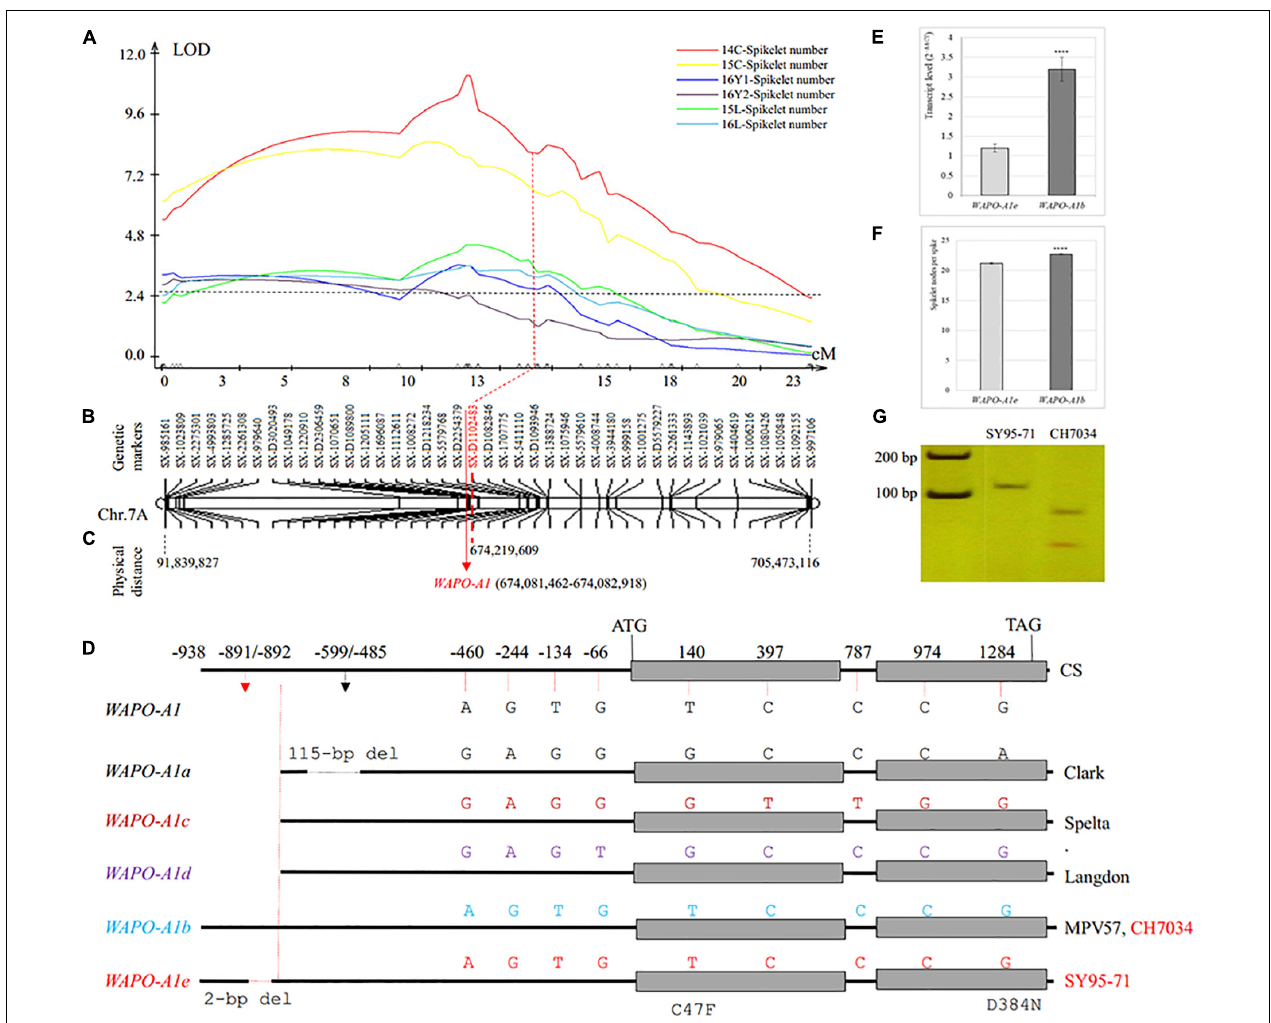
FIGURE 3 | Genetic and physical maps of SNS QTL QSns.sxau-7A and allelic variation in the candidate gene WAPO-A1 . (A) Mapping of the QSns.sxau-7A locus. The phenotypic data was collected in Chengdu in 2014 (14C) and 2015 (15C), two experimental locations in Yuncheng in 2016 (16Y1 and 16Y2), and Linfen in 2015 (15L) and 2016 (16L). LOD value is indicated on Y axis, and genetic distance (cM) is indicated on X axis. (B) Genetic map of QSns.sxau-7A . The SX plus 8-digit SNP codes are markers from SNP from 17K SNP chips, and the SX-D plus 8-digit SNP codes are markers from the 35K DArT chips. (C) Physical map of QSns.sxau-7A . The physical locations of markers and candidate gene WAPO-A1 are shown based on the Chinese Spring genome sequence of RefSeq v1.1. (D) A diagram of differences in multiple WAPO-A1 alleles. Allelic variation in WAPO-A1a through WAPO-A1d is cited from the previous study (Kuzay et al., 2019). CH7034 has the same WAPO-A1b allele as MPV57. SY95-71 has WAPO-A1e , which is a novel allele. The only difference between WAPO-A1b and WAPO-A1e is that WAPO-A1e has a 2-bp deletion in its promoter. (E) Comparison of transcript levels between the SY95-71 WAPO-A1e allele and the CH7034 WAPO-A1b allele. (F) Comparison of SNS between the SY95-71 WAPO-A1e allele and the CH7034 WAPO-A1b allele. (E–F) A t -test was performed to show differences in the transcript levels between the two alleles, with “****” indicating a significant difference ( p < 0.0001). The bars indicate standard error. (G) A diagnostic PCR marker for WAPO-A1 between the SY95-71 and CH7034. The PCR products were digested with restriction enzyme HypCH4V to distinguish between the SY95-71 WAPO-A1e allele with the 2-bp deletion and the CH7034 WAPO-A1b allele without the 2-bp